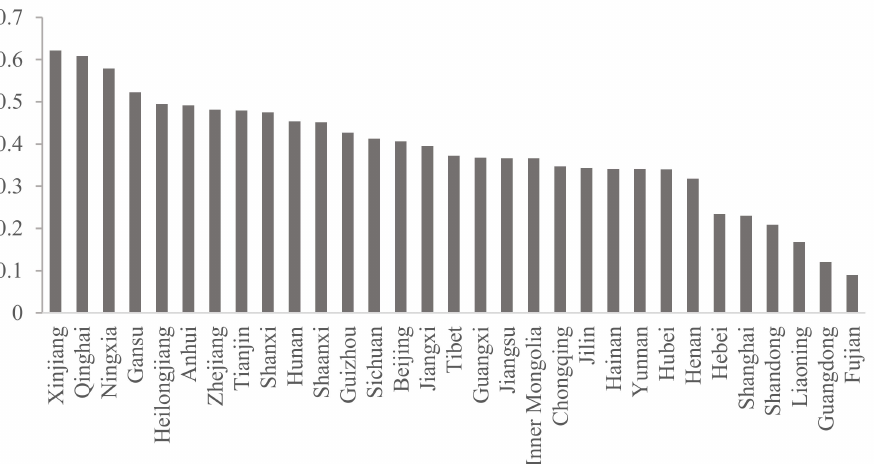
Figure 4. Mean of coordinated development index of population urbanization and affordable housing (from 2010 to